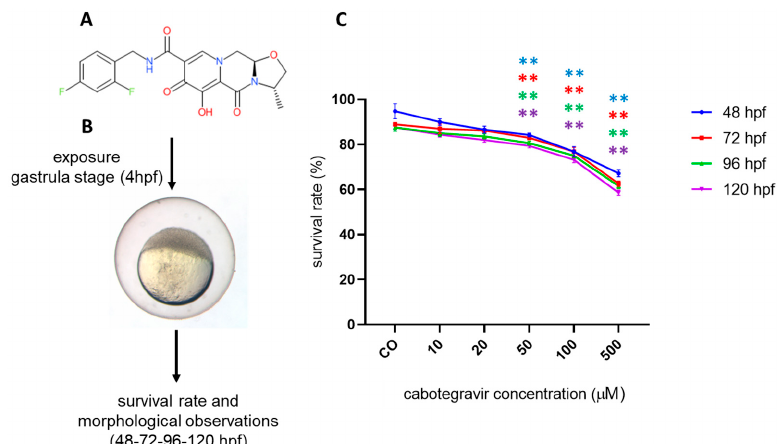
Figure 1. Survival rate of zebrafish embryos at different developmental stages (hours post fertilization, hpf) after exposure to cabotegravir (CAB) by the immersion method. ( A ) CAB chemical structure. ( B ) Overall experimental design. ( C ) Dechorionated zebrafish embryos were exposed at gastrula stage (4 hpf) to drug solvent only (fish water plus 0.1% dimethyl sulfoxide, DMSO) [CO] or CAB, dissolved in fish water containing 0.1% DMSO. X-axis shows drug doses used for exposure of embryos; Y-axis shows the corresponding survival percentages at the different developmental stages (48 hpf, blue line; 72 hpf, red line; 96 hpf, green line; 120 hpf, violet line). Results are expressed as mean ± SD of three independent experiments, with 30 embryos for each experiment and each treatment. (** p < 0.005 vs. control group).